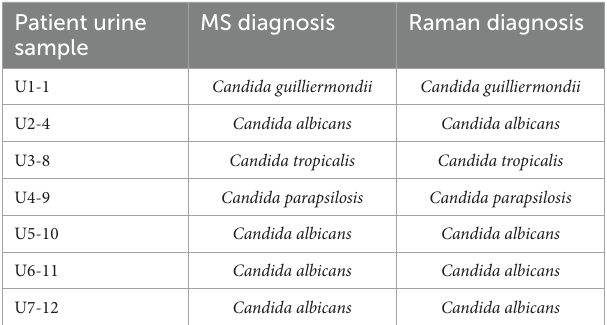
TABLE 1 Diagnosis of 7 uncultured UTI samples by MS and Raman